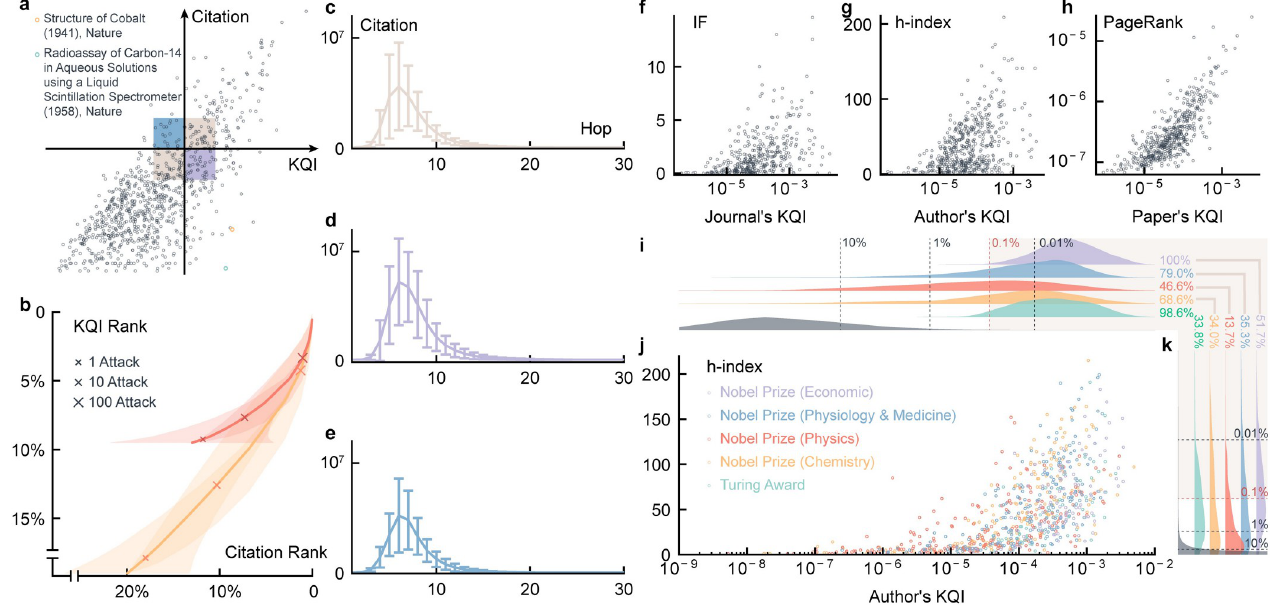
Fig 3. KQI-based ranking and comparisons. a, Quadrants of KQI and citation. The scatter diagram shows the triangle at the lower right, which implies that higher citations correspond to higher KQI, but lower citations do not mean lower KQI. Two papers shown in the delta quadrant give examples where valuable literature receives few citations. b, The impact of artificial attacks on rankings. Plot the change curve of KQI and citation rankings by deliberately citing certain articles, adding 1,10,100, or more citations, respectively. The shadow represents the standard deviation of the sample. After the attack, the citation ranking significantly changes more than the KQI ranking. c-e, Citation changes for different hops. By sampling the three shaded areas in a , the number of papers derived from these papers with different hops is shown. It can be observed that articles in region d have a greater aftereffect, while those in region e have a lower aftereffect. f-h, Comparison among h-index, impact factor, PageRank, and KQI [40,41]. The scholars with high citations are more inclined to have higher KQI, while the impact factor of the journal has little relationship with its KQI. KQI and PageRank show a significant positive correlation. i-k, Laureates distribution. The h-index and KQI statistics of Nobel Prize winners (Economics, Physiology & Medicine, Physics, Chemistry) and Turing Award winners show that KQI can better distinguish laureates from ordinary authors (grey). 100% of Nobel Prize winners (Economics) are ranked in the top one-thousandth of KQI, while 51.7% are ranked in the top one-thousandth of h-index. Other results are